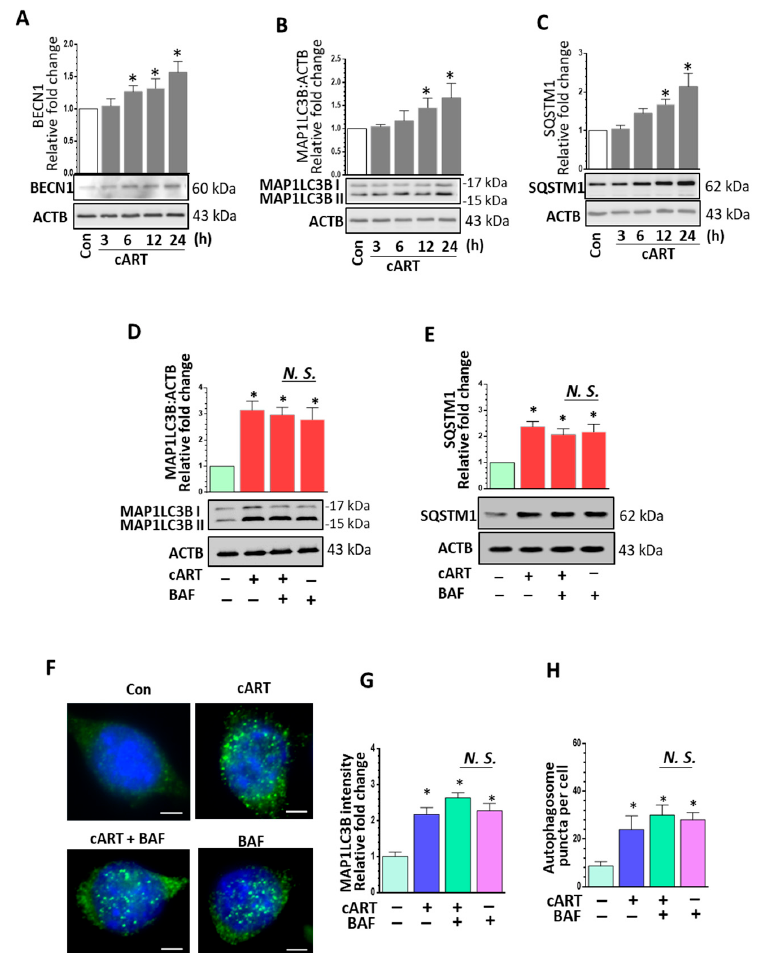
Figure 2. Exposure of rPMs to cART resulted in dysregulated autophagy. ( A – C ) Representative western blots and bar graphs showing cART-mediated increased expression levels of autophagy markers beclin 1 (BECN1), microtubule-associated protein 1 light chain 3 beta (MAP1LC3B), and sequestosome 1 (SQSTM1) in rPMs. ( D , E ) Representative western blots and bar graph showing MAP1LC3B lipidation and SQSTM1 accumulation in rPMs treated with cART, bafilomycin (BAF, autophagosome fusion inhibitor), and cART + BAF. ( F ) Representative fluorescent-microscopic image showing cART-mediated increased MAP1LC3B puncta (autophagosomes). ( G , H ) Representative bar graphs showing cART-mediated increased intensity of MAP1LC3B and increased numbers of MAP1LC3B puncta. Data is from three independent experiments. ACTB served as a protein loading control for western blots. Data are expressed as means ± SEM and were analyzed using student t-test or one-way ANOVA. *, p < 0.05 vs. control; N.S.,